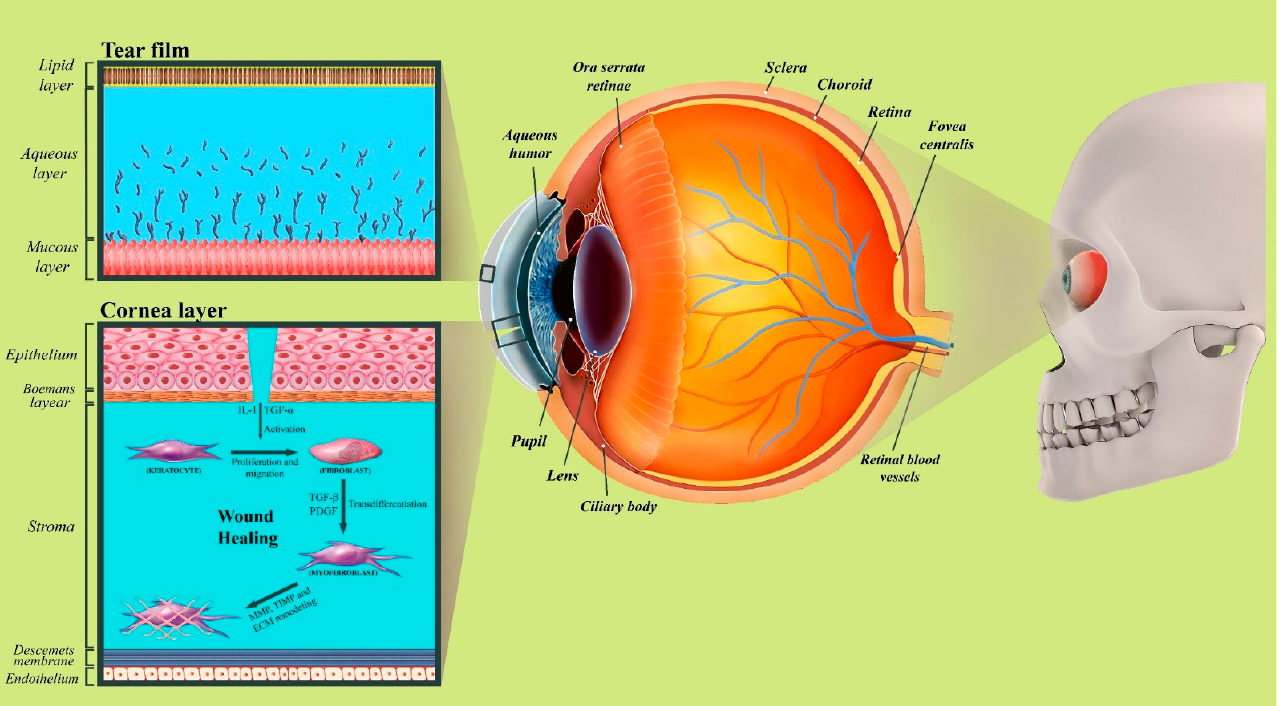
Figure 1. The anatomical structure of the eye and cornea tissue in the human cornea wound healing mechanism. Photoshop 2020 was used to create this figure.